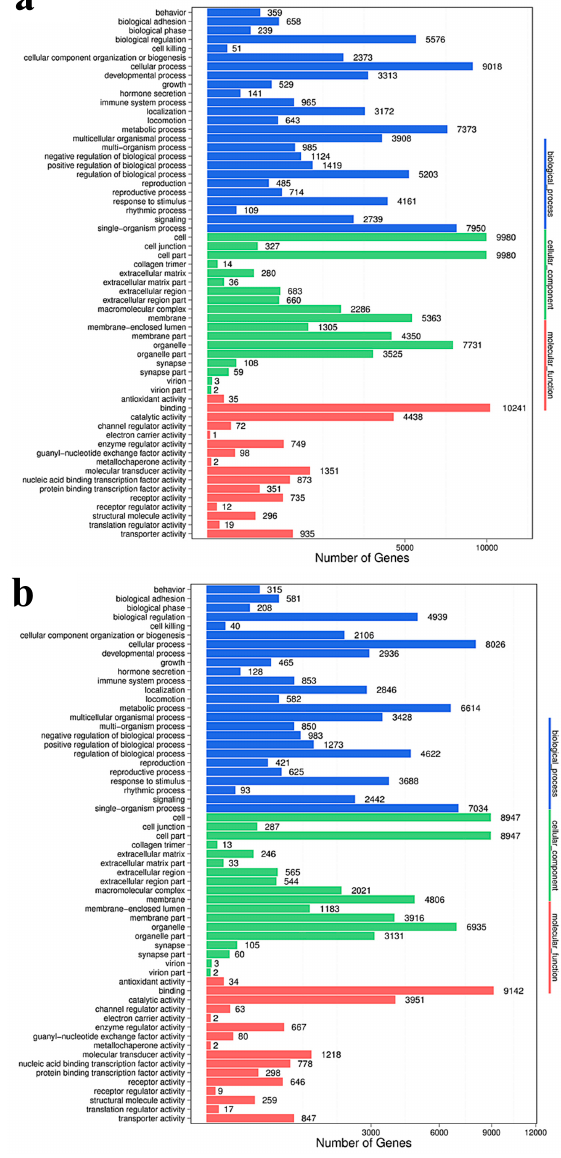
Figure 6. GO classification map of target genes of differential microRNAs. ( a ) 3 μ g/mL group VS control group; ( b) . 30 μ g/mL group VS control group. X -axis represents number of DEGs (the number is presented by its square root value), Y -axis represents GO terms. All GO terms are grouped into three ontologies: blue is for biological processes, brown is for cellular component, and orange is for molecular function.